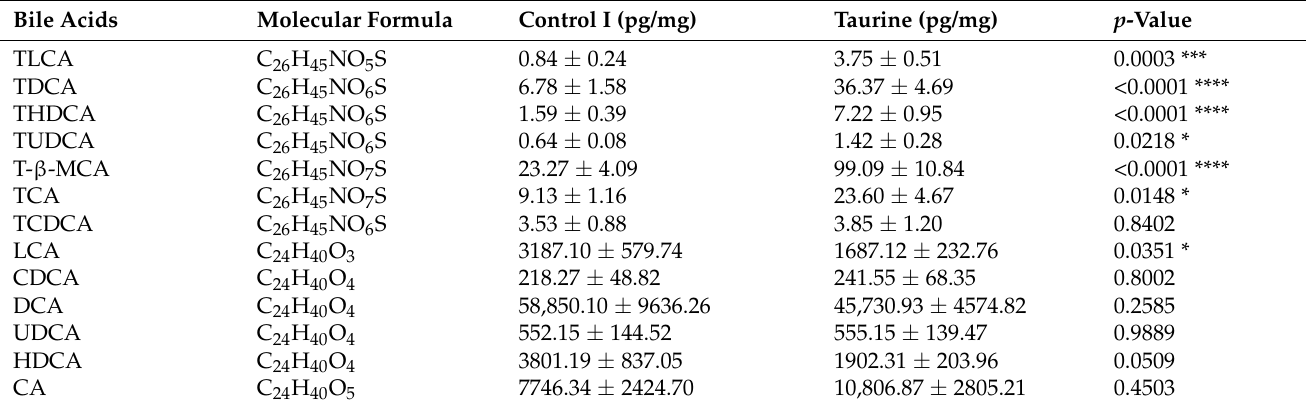
Table 1. Fecal bile acid concentration of mice after taurine supplementation.